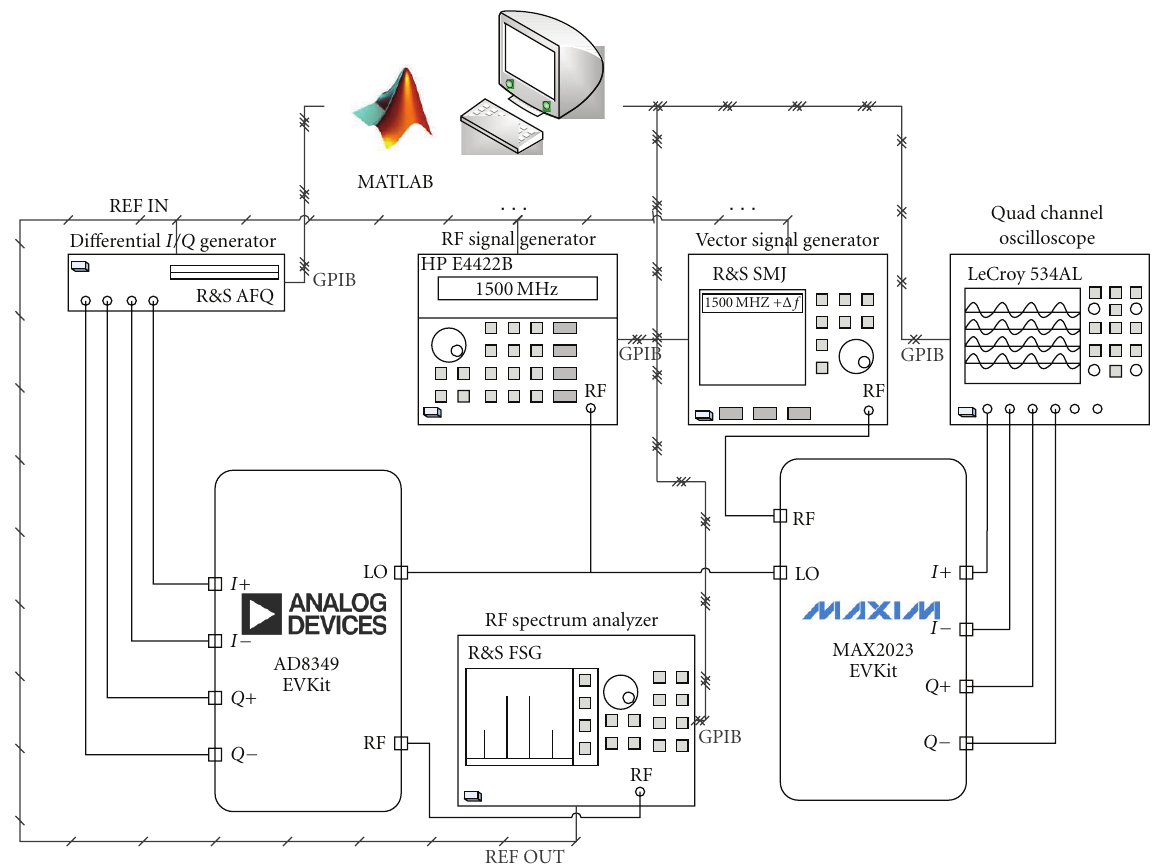
Figure 11: General structure of the measurement setup consisting of laboratory instruments and I/Q modulator and demodulator. domain for channel distortions and transmitter I/Q